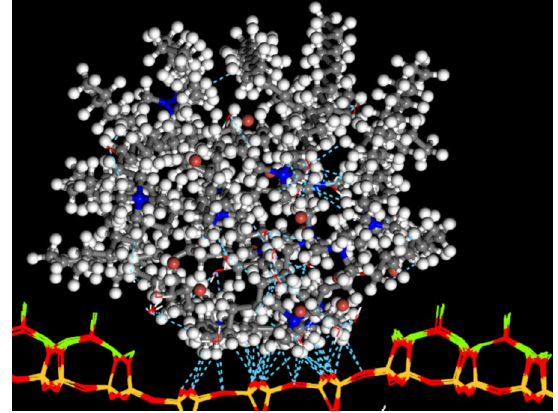
Figure 12. Final snapshot of the severed 15 CTAB molecules on the periodic surface after 1.25 ns.